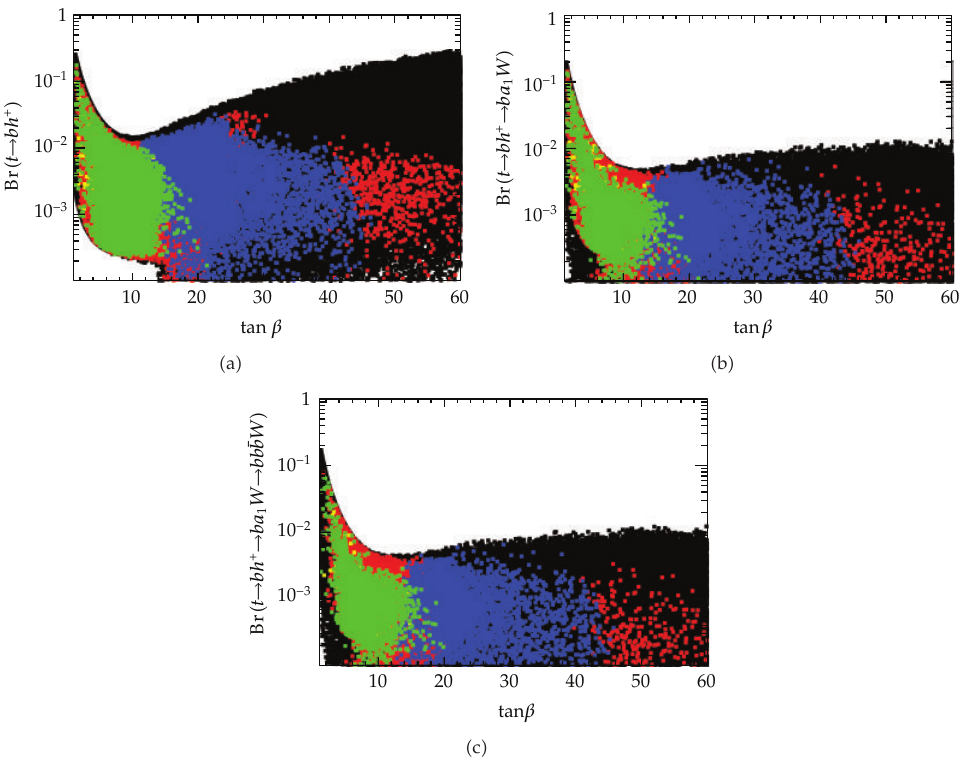
Figure 3: The branching ratios for the decay chains t → bh (cid:8) , t → bh (cid:8) → ba 1 W , and t → bh (cid:8) → ba 1 W → bbbW , respectively, when scanning over the parameters in the scenario under consideration (cid:2) see text for details (cid:3) with the various constraints applied and only considering points with m h ± < 160GeV. The colour coding is the same as in Figure